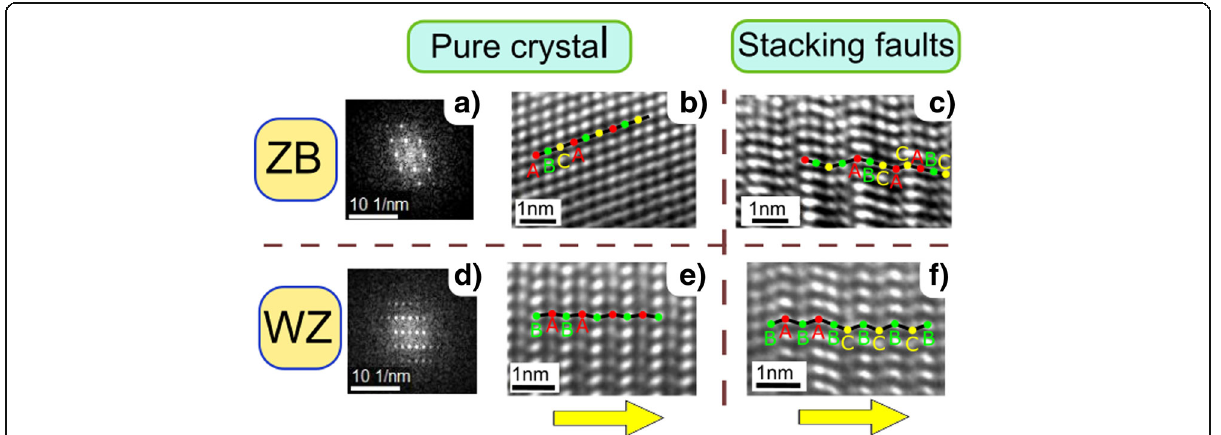
Fig. 2 Crystal structure analysis. HR-TEM images of InAs NWs, illustrating the ZB and WZ crystal structures with and without stacking faults. The yellow arrows indicate the [111] growth direction. The colored dots and the black lines are guidance for the eyes to retrace the stacking characteristic. a FFT diffraction pattern for defect-free ZB. b , c ZB structure. d FFT diffraction pattern for defect-free WZ and e – f WZ